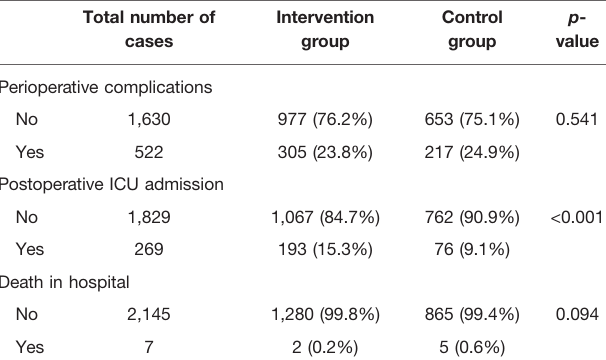
TABLE 4 | Comparison of the perioperative medical complications during hospitalization, postoperative ICU admission and total mortality during hospitalization between the two